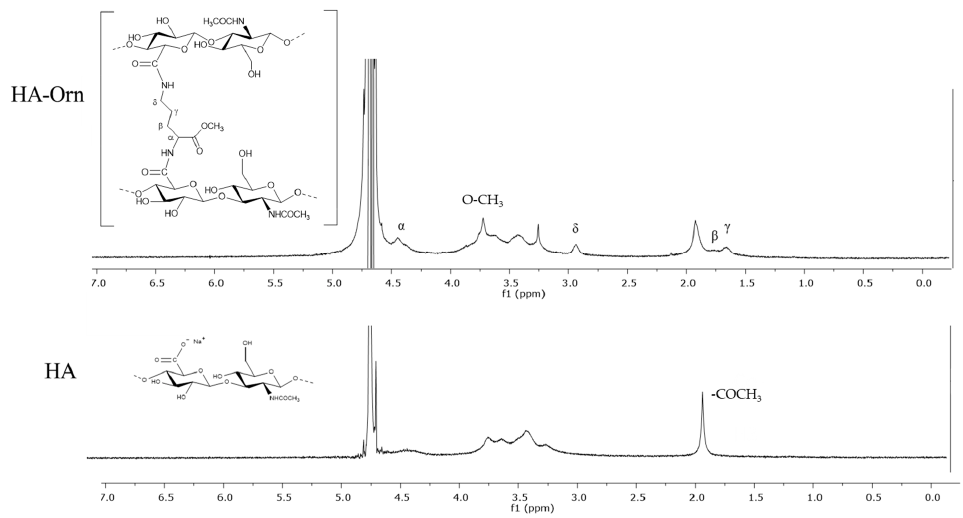
Figure 2. 1 H-NMR spectrum of native HA and cross-linked HA–Orn recorded in D 2 O. The spectra of hyaluronic samples gave enlarged signals due to the viscosity of the product in the solution. The peaks of the methyl groups of the Ornithine side chain were selected since they did not overlap with the peaks of the native HA, allowing for an easy calculation of the degree of